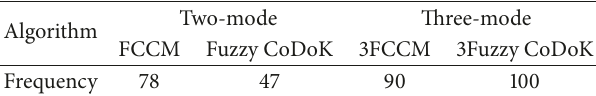
Figure 4: Estimated intrinsic connection matrix Table 1: Comparison of frequencies of plausible solutions in 100